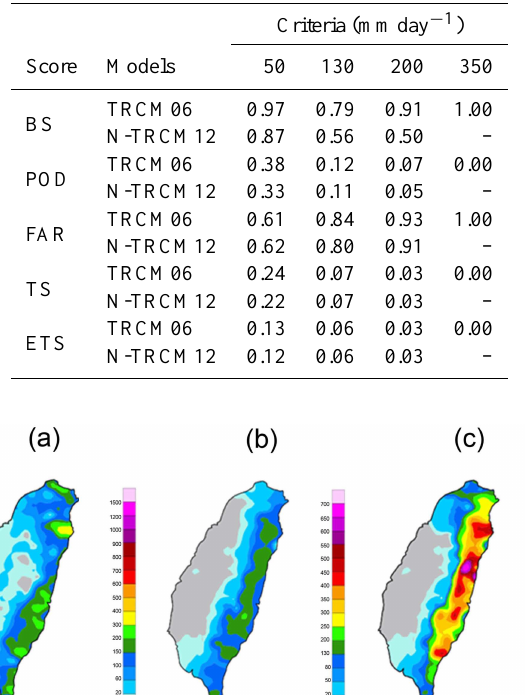
Table 6. Validation results for the statistical parameters of indepen- dent northward-moving typhoons that hit Taiwan in 2007–2011 us- ing contingency table analysis.